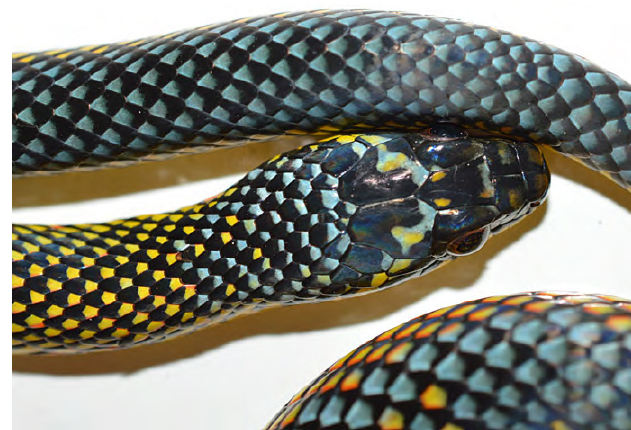
Figure. 3. Photo showing blue coloration of Liophis dorsocorallinus on a specimen (freshly euthanized; CIRA-254) collected during a herpetofaunal survey of the Reserva de Biósfera Estación Biológica del Beni (Depart- mento del Beni, Provincia de Yacuma). This unique characteristic has not been previously described for the